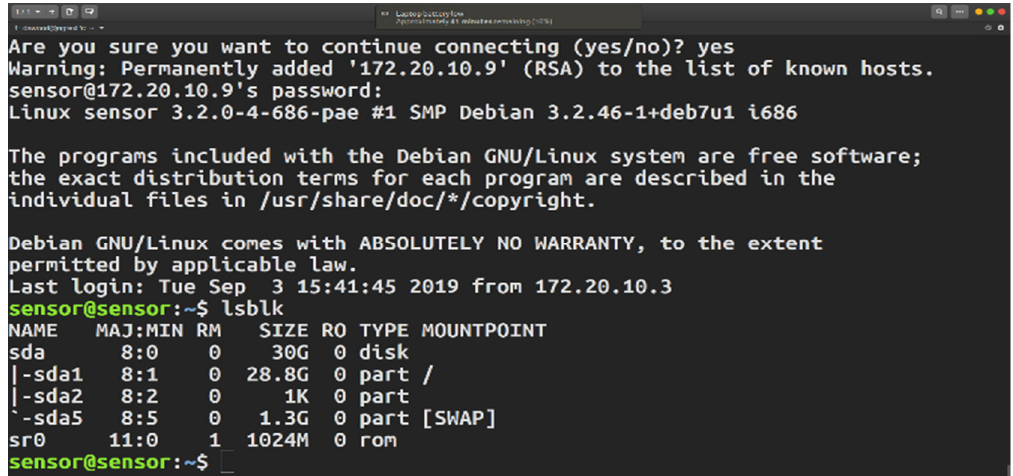
Fig. 7: IEMS control due to a DoS attack leads to significant problems